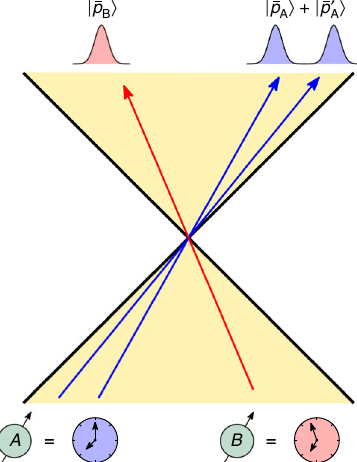
Fig. 1 Quantum time dilation. Two clocks are depicted as moving in Minkowski space. Clock B is moving in a localized momentum wave packet with average momentum (cid:2) p B , while clock A is moving in a superposition of localized momentum wave packets with average momentum (cid:2) p A and (cid:2) p 0 A . Clock A experiences a quantum contribution to the time dilation it observes relative to clock B due to its nonclassical state of